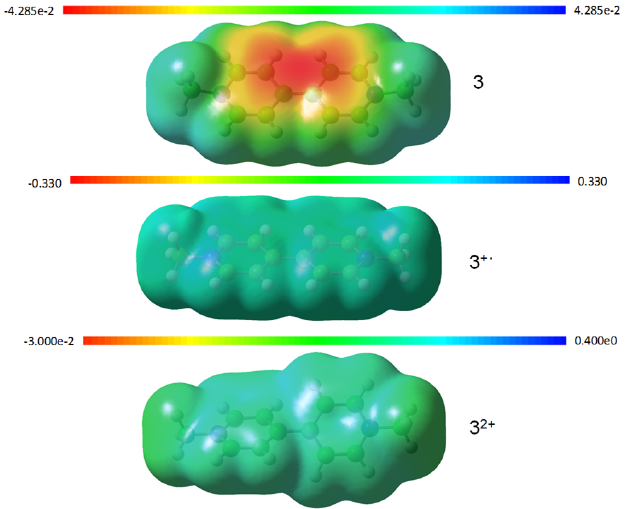
Figure 3. B3LYP/6–31+G* molecular electrostatic potential for the different oxidation states of 3